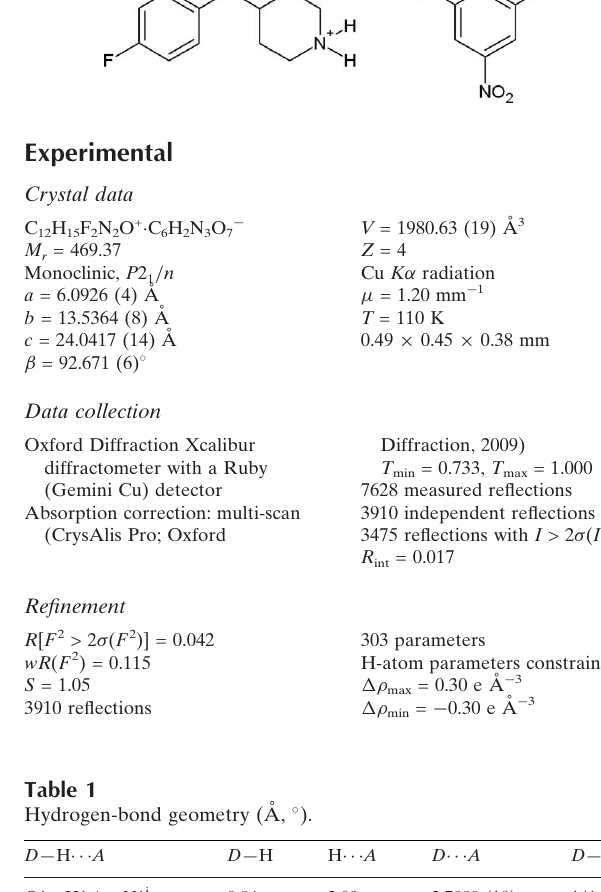
Hydrogen-bond geometry (A˚ , (cid:4) ). D —H (cid:2)(cid:2)(cid:2) A D —H